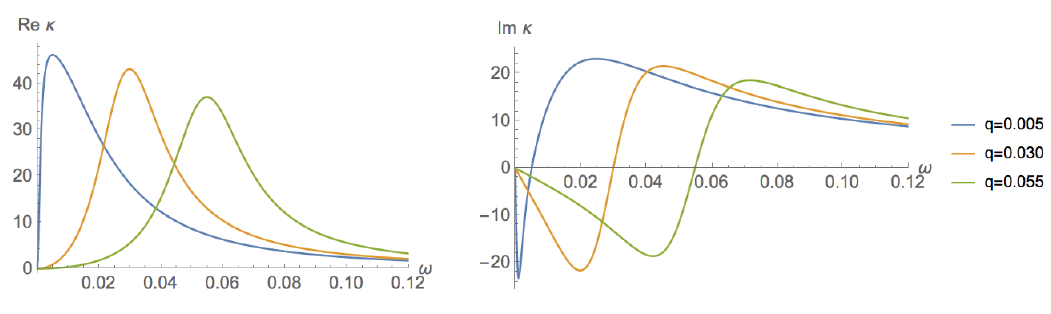
Figure 5 . Longitudinal conductivity for A 0 = 0 : 4 and varying q .